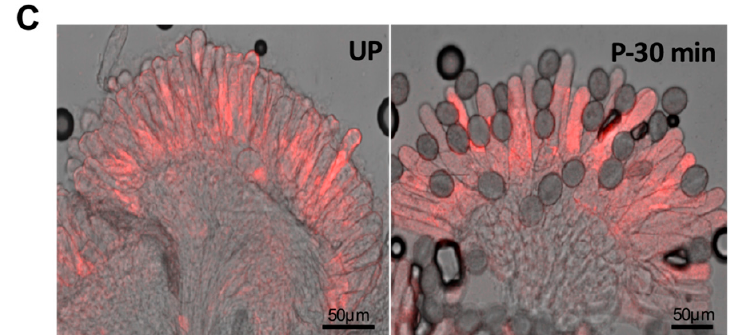
Figure 5. Expression analysis of glyoxalase I family members and imaging of methylglyoxal in reproductive tissues of Arabidopsis. ( A ) Heat maps representing the absolute expression values of glyoxalase genes in Arabidopsis stigma, pistil tissue (consisting of ovary) and dry pollen from ATH1 genome array. Values were generated using BAR Expression Browser ( B ) Visualization of methylglyoxal through MBo staining: (I) DIC image of an Arabidopsis stigma; (II) Stigma stained with MBo; (III) Anther and pollen stained with MBo; (IV) Female gametophyte stained with MBo; ( C ) Comparison of intensity of BnGLO1-RFP in Arabidopsis stigmas before and after 30 min of pollination through confocal microscopy. Scale bars = 50 μ m.